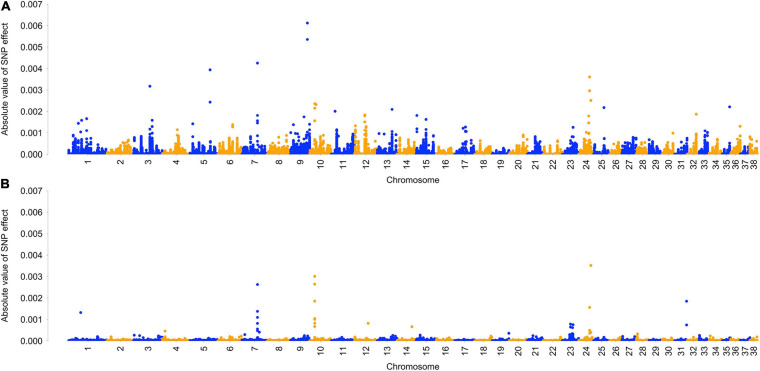
Manhattan plot of genome-wide association analysis of ACL rupture case and control dogs with and without biological priors. Plot shows average SNP effect across five reps of BayesRC algorithm (A) and BayesR algorithm (B).